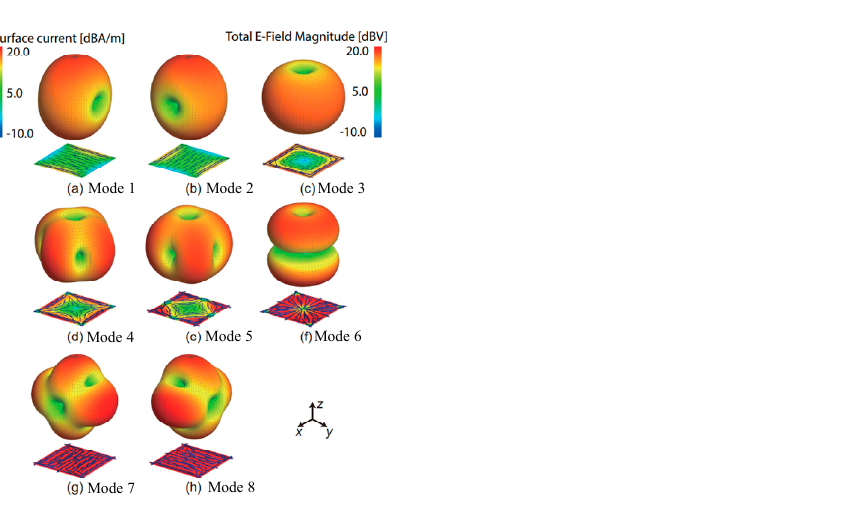
Table 5. Comparison of different IBFD SIC techniques in the AP domain